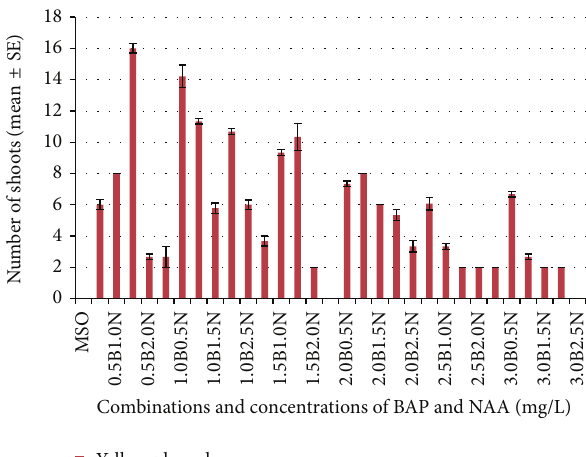
Figure 1: Effects of combinations and concentrations of BAP and NAA on lotus shoots formation from yellow plumule